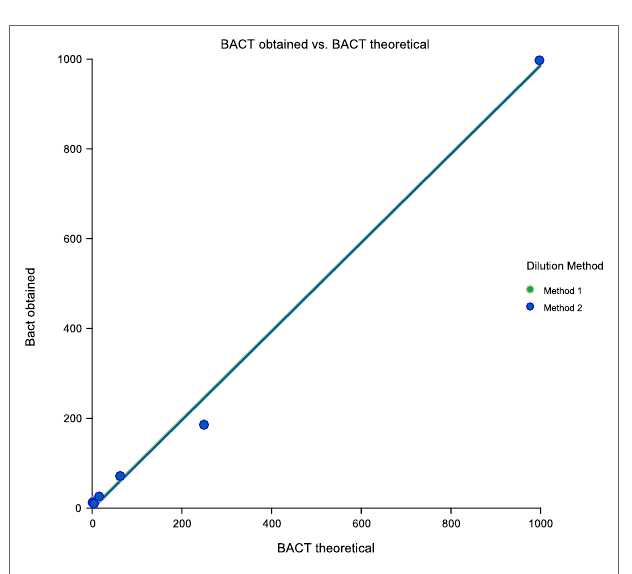
FIgURe 9 | Scatter diagram of obtained and theoretical bacteria in sample